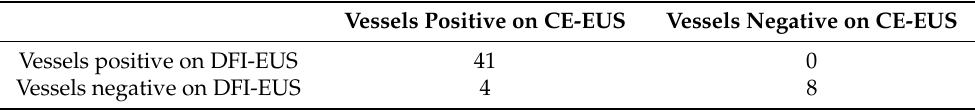
Table 4. Correlation between visualization of vessels in pancreatobiliary lesions by e-FLOW EUS and CE-EUS. Vessels Positive on CE-EUS Vessels Negative on CE-EUS Vessels positive on e-FLOW 24 0 EUS Vessels negative on e-FLOW 21 8 EUS CE-EUS, contrast-enhanced